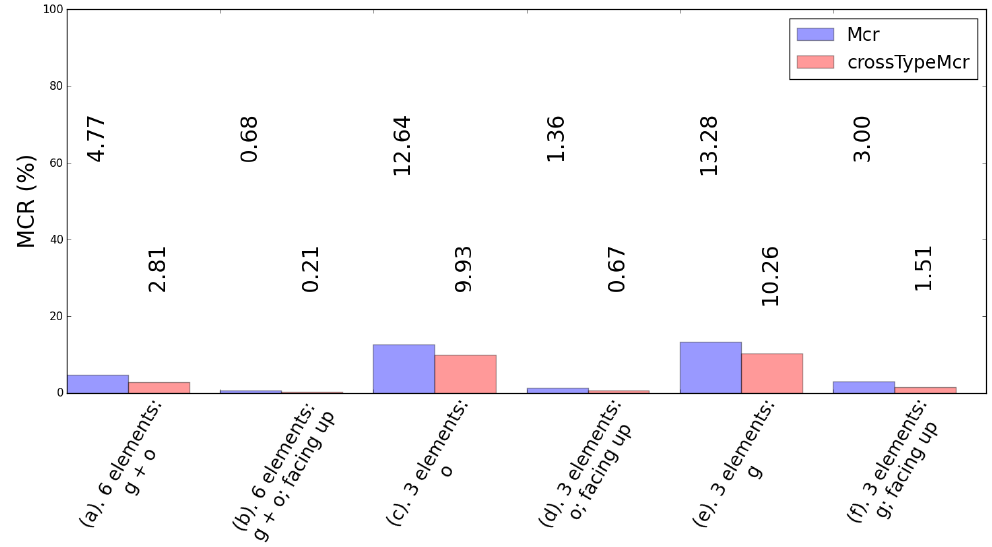
Figure 8. Recognition comparison using different attributes. “g” represents the geomagnetic informa- tion; “o” represents the orientation